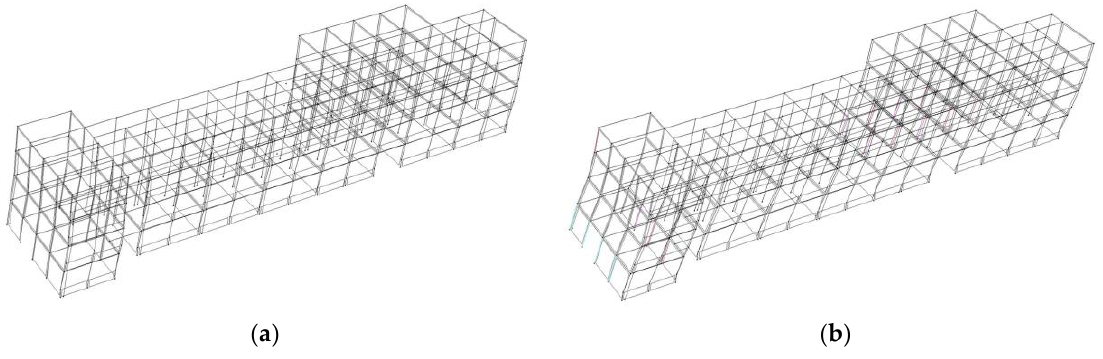
Figure 26. Hinge properties with WKDS. ( a ) DBE level, ( b ) MCE level.